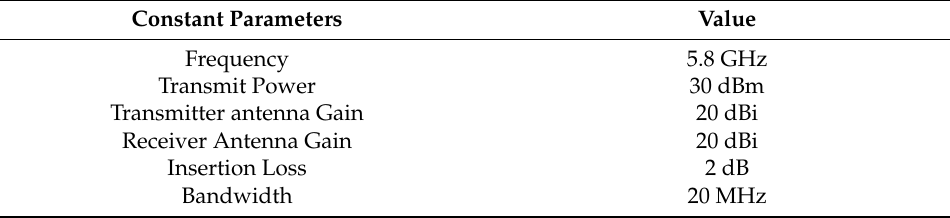
Table 2. Constant parameters and values of Wi-Fi equipment installed.